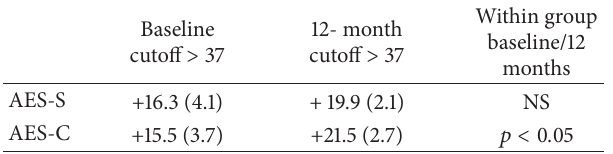
Table 7: Apathy scores, AES-C, clinician rated apathy evaluation scale; AES-S, self-report rated apathy evaluation scale. Values are mean (SD). NS = not significant. We report the differences from the cutoff